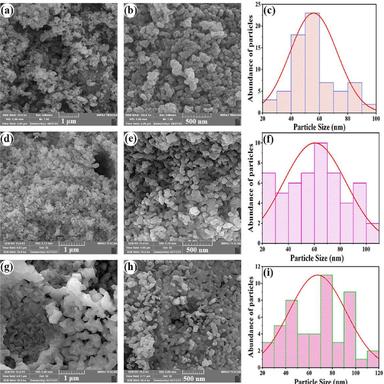
FE-SEM images and particle size distribution of (a–c): S1, (d, f): S3 and (g, i): S4.